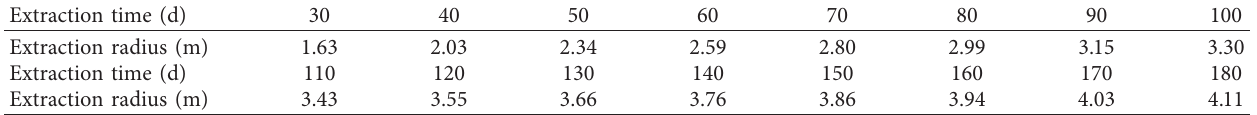
Table 2: Extraction radius at different extraction